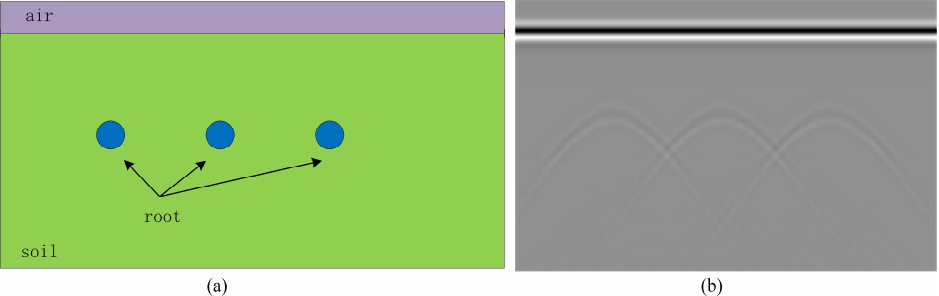
Figure 14. Root simulation model. ( a ) An example for the geometric model in the simulated experiment. ( b ) The corresponding B-Scan image from gprMax.